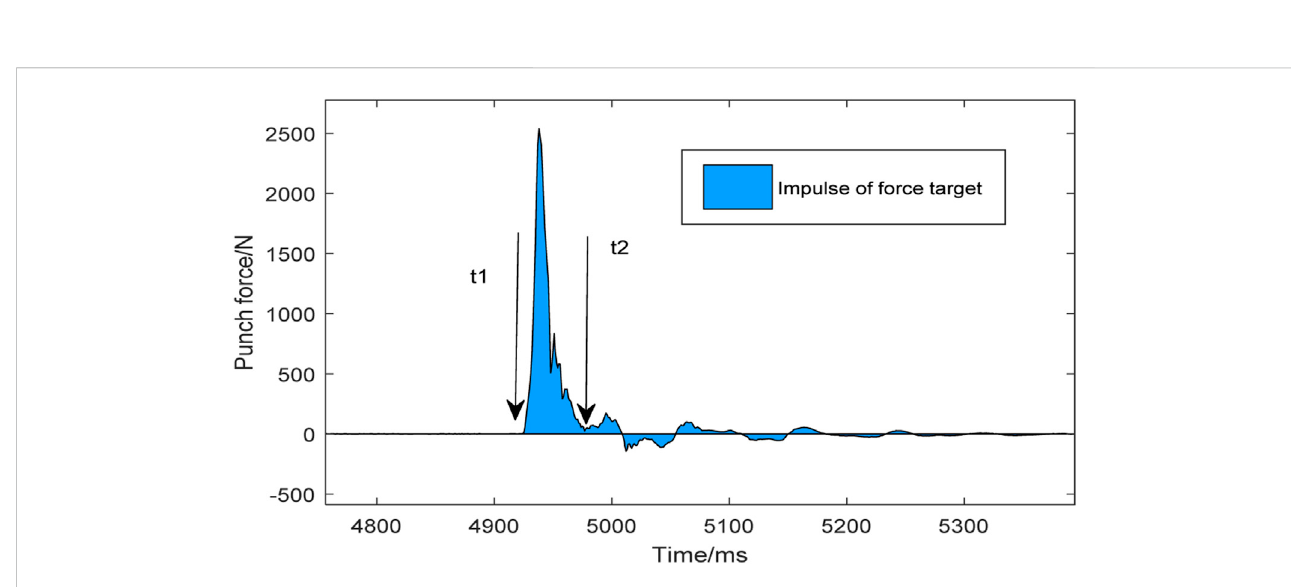
FIGURE 2 Impulse of a straight